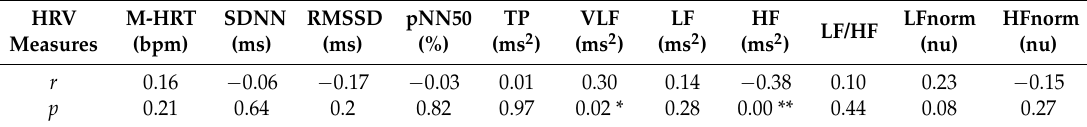
Table 3. Correlation analysis between depression and HRV parameters in mean